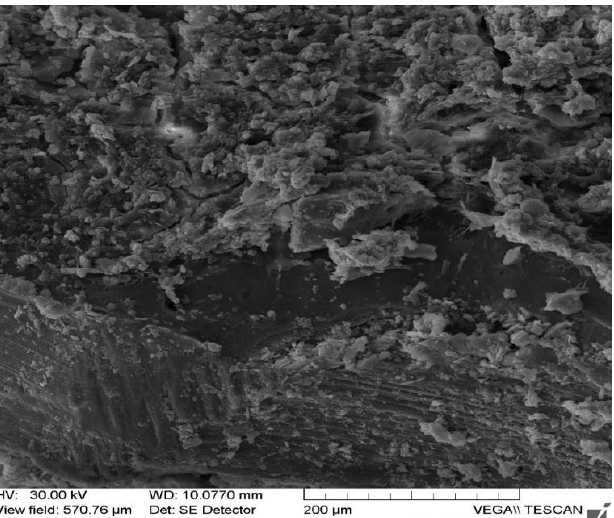
Figure 10. Presence of newly formed bone bands near the implanted material (Bio Aggregate).